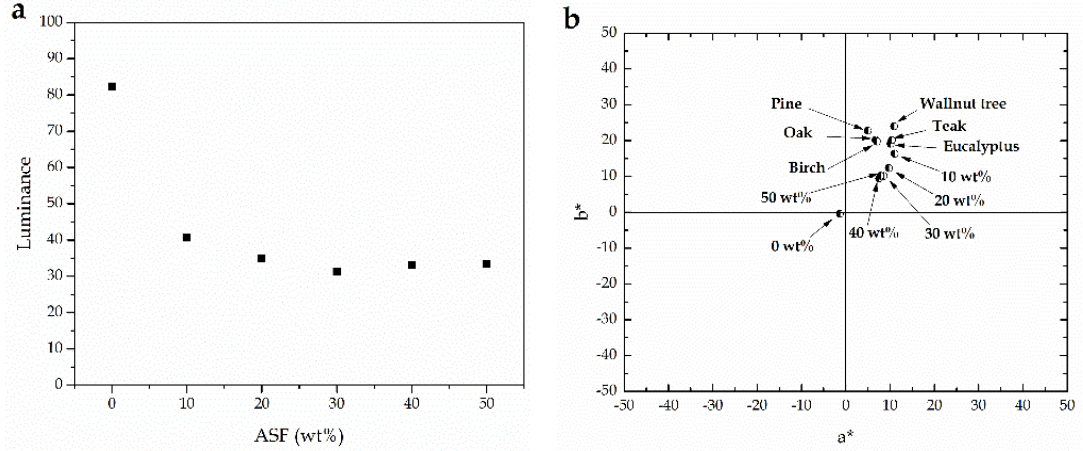
Figure 2. ( a ) Variation of the luminance ( L* ) and ( b ) colour coordinates ( a*b* ) of PBS/ASF/MLO composites with varying ASF loading.